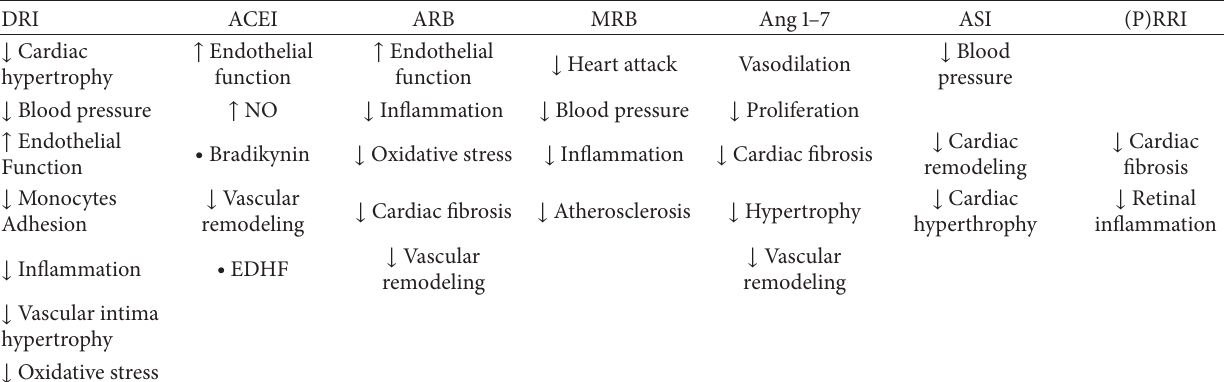
Figure 1: Schematic representation of various molecular factors activated by RAAS effectors and cross-talk between RAAS effectors and molecular factors involved in signaling pathways with role in vascular inflammation and remodeling. Double arrow: cross-talk; single arrow: increased expression or stimulation. Table 1: Pharmacological effects of RAAS inhibitors on cardiovascular